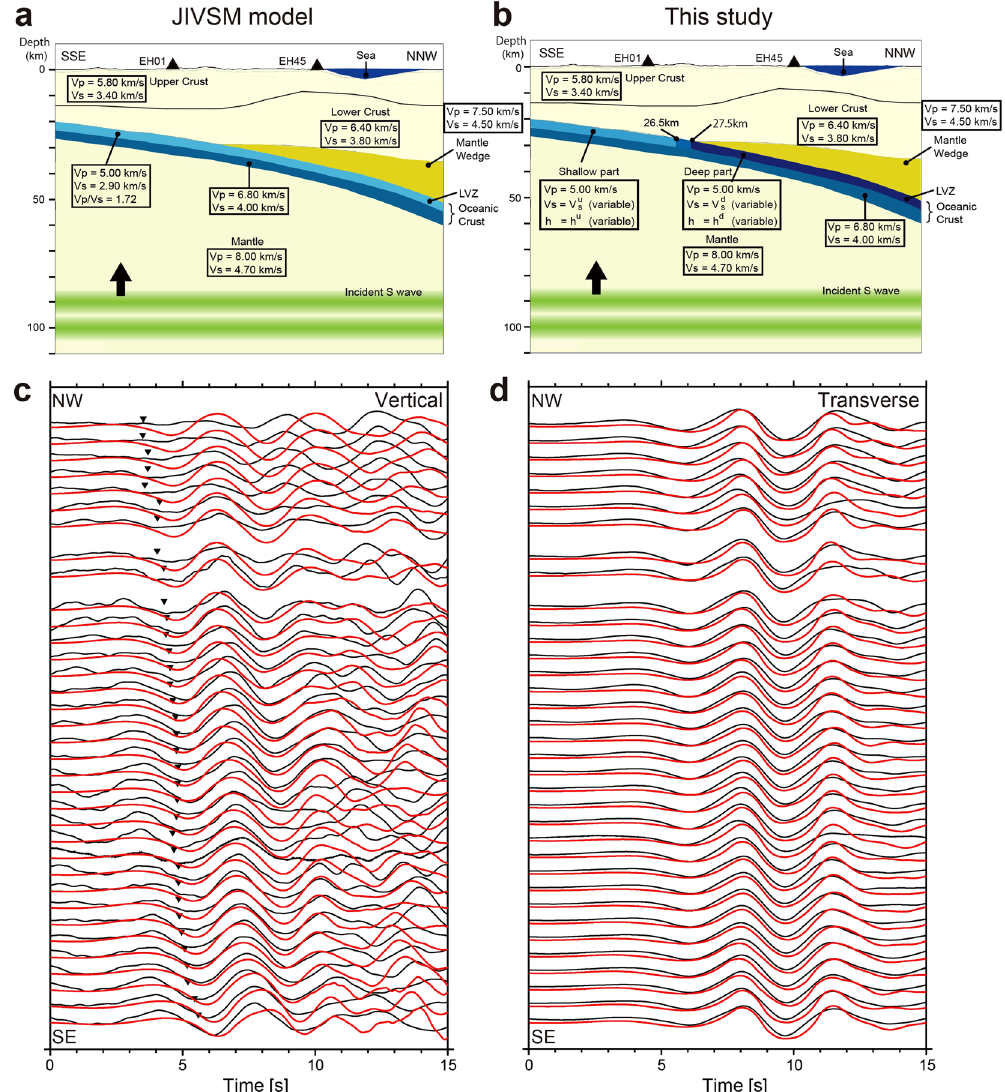
Figure 3. ( a) Vertical cross-section of the initial structural model (JIVSM) along the seismic linear array, used in FDM simulations 20 . ( b) Revised model in the present study. There are four variable parameters charactering physical properties of the LVZ. The S -wave velocity and the layer thickness in the partitioned LVZ are labeled V su , h u in the shallower part of the LVZ, and V sd , h d in the deeper part, respectively. ( c) Comparison of observed (black) and simulated (red) vertical component waveforms, from EH01 to EH35 for a constant layer thickness model. Black inverse triangles denote arrivals of observed ScSp phases. ( d) Transverse components. The simulated waveforms were calculated using the best-fit parameters, V su = 2.9 km/s, V sd = 2.2 km/s and h = 6 km. At each station, a relative amplitude between ScSp and ScS phases is